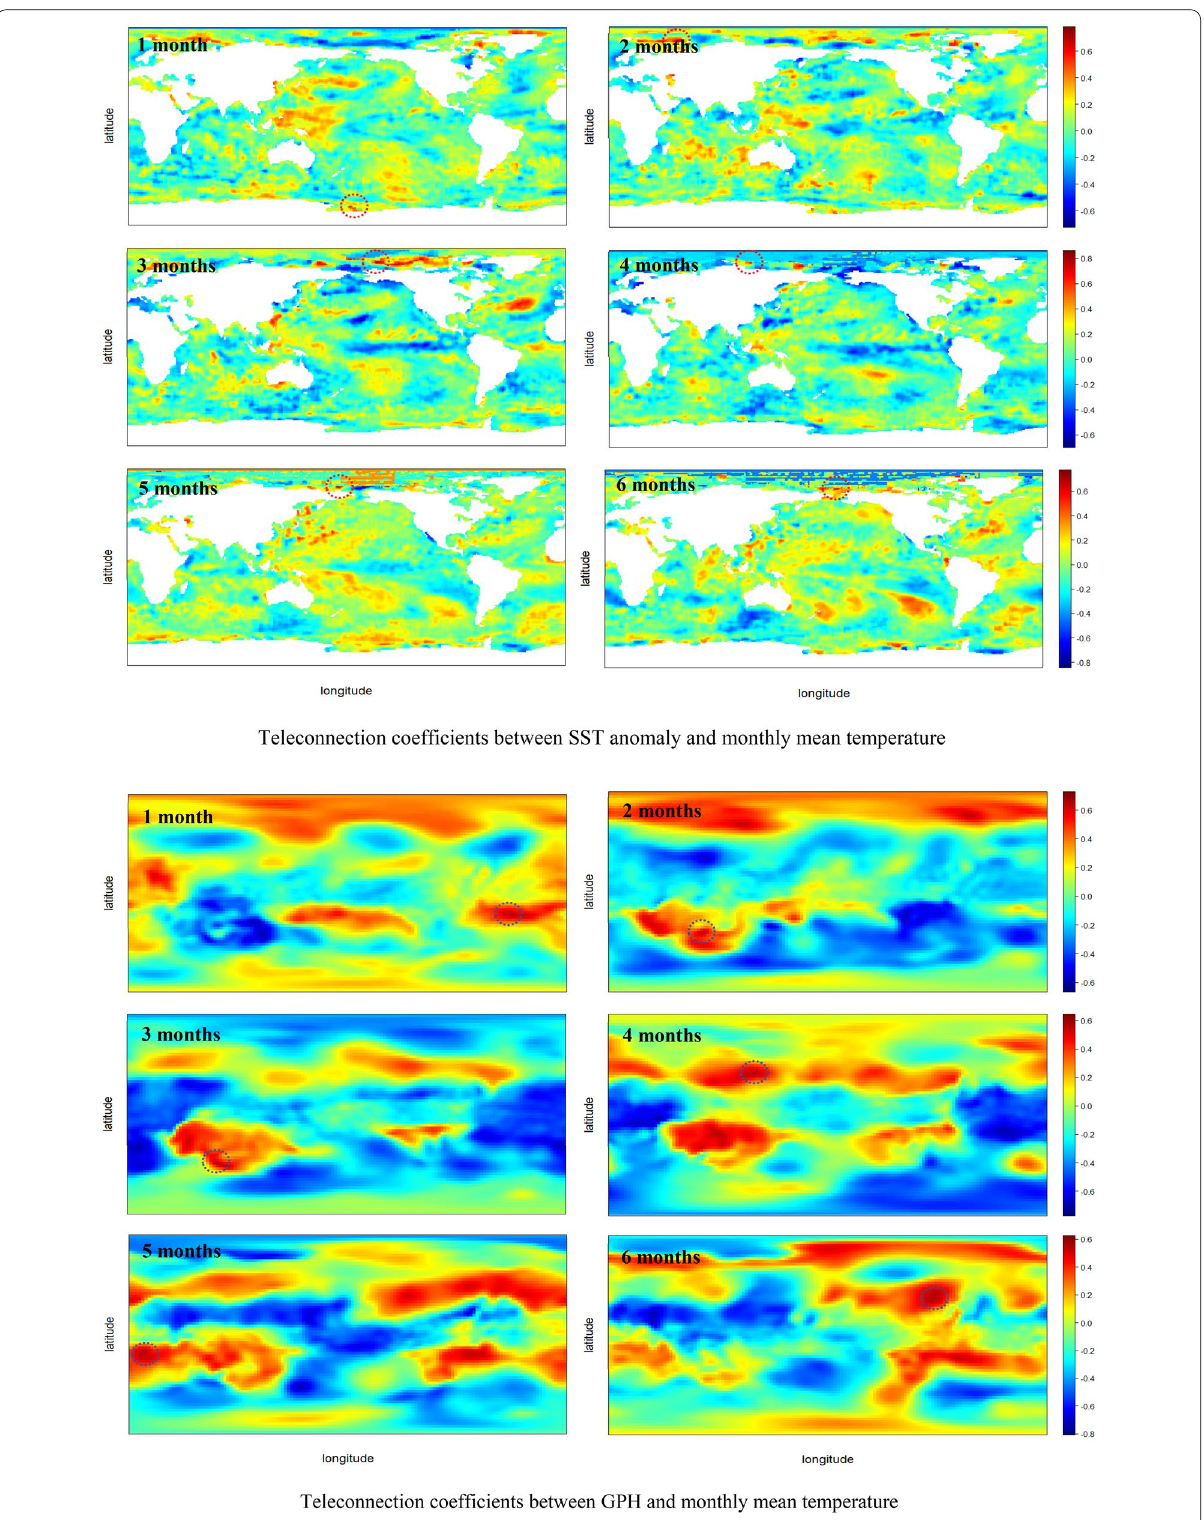
Fig. 29 Teleconnection coefficients between the global-scale climate indices and monthly mean temperature during the El Niño